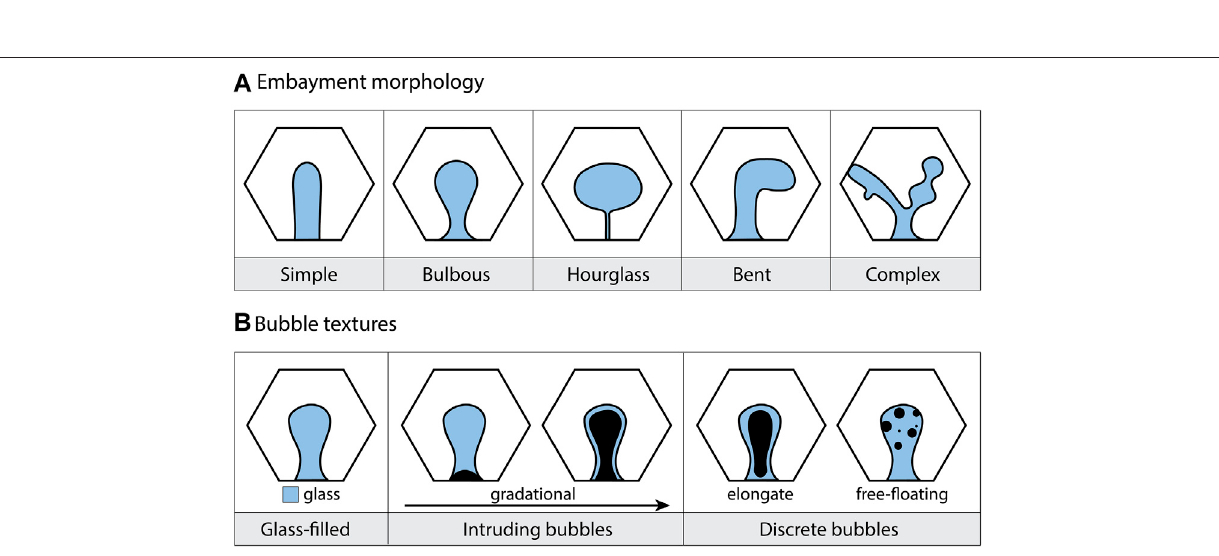
Frontiers in Earth Science |